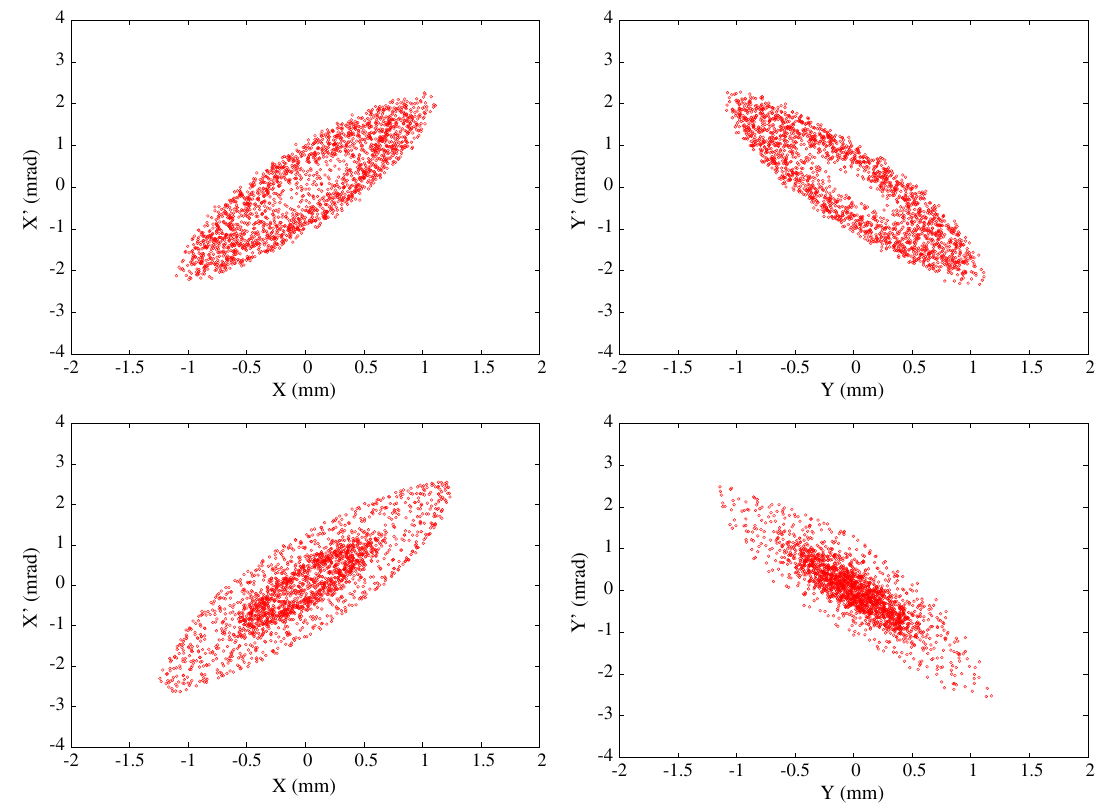
FIG. 4. Stroboscopic plot (every 10 periods) of phase space evolution of a test particle from the symplectic-spectral model (top) and from the PIC-finite difference model